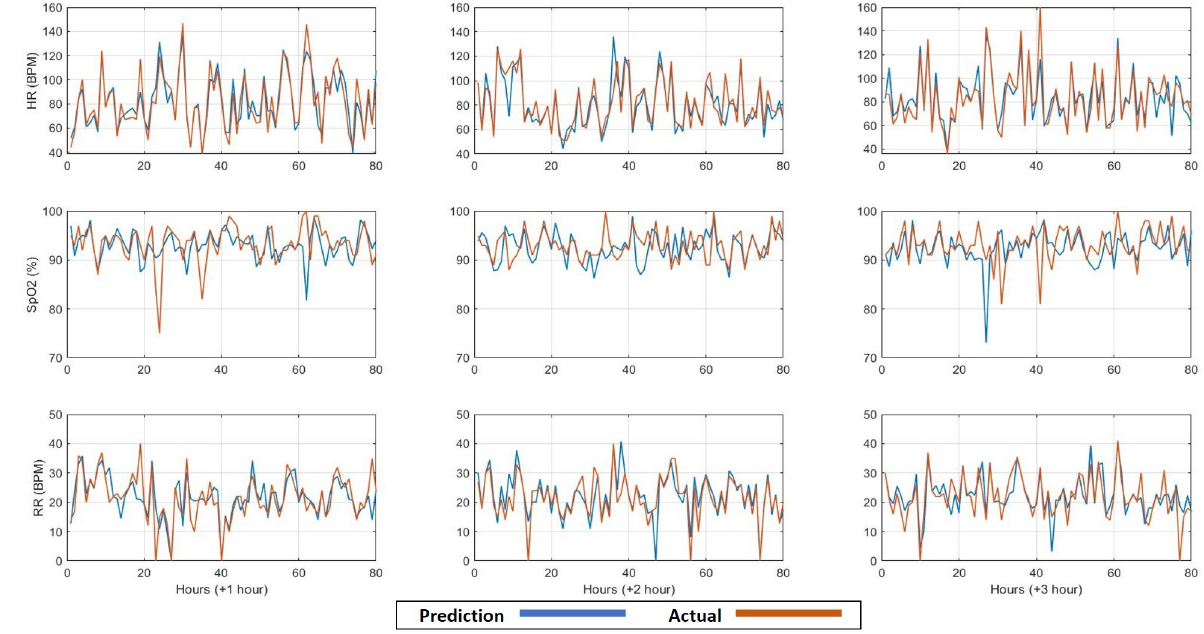
Figure 8. The comparison between the predicted and the actual values for the upcoming three hours (+1, +2, +3 h) of the vital signs: heart rate (HR), oxygen saturation (SpO 2 ), and respiration rate (RR), respectively, based on observation rate of one observation/5 min.